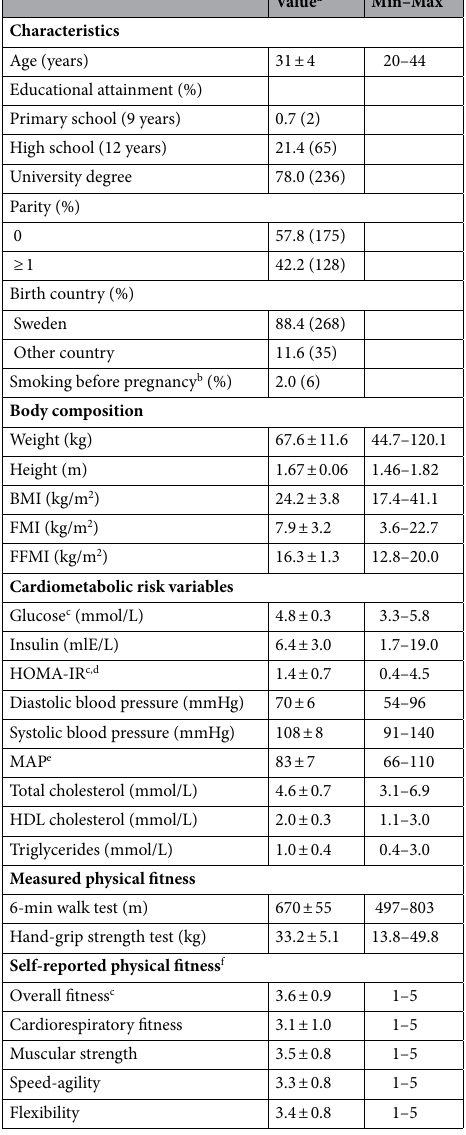
Table 1 provides information on the wom- en’s background characteristics, body composition, cardiometabolic risk variables, and self-reported and meas- ured fitness levels. In general, study participants were young women (mean age 31 years), highly educated (78% university degree), and most of them (88%) were born in Sweden. Figure 1 shows the distribution of answers to